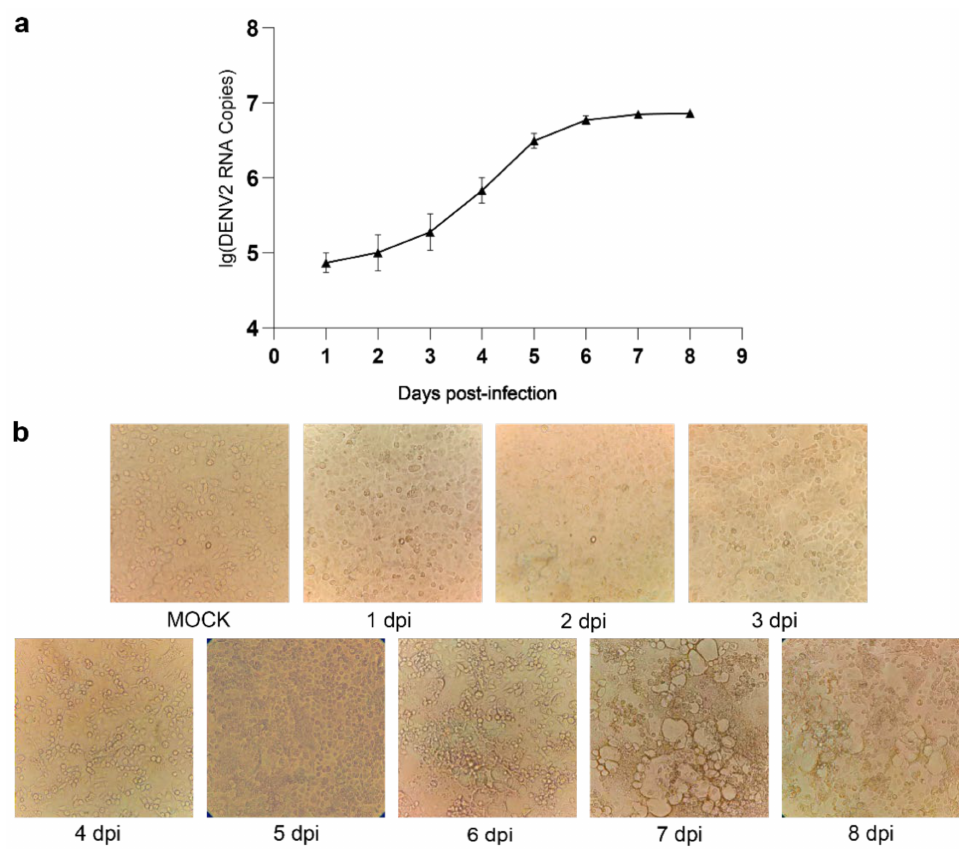
Figure 1. Viral growth kinetics of ( a ) and morphological changes in ( b ) C6/36 cells infected with DENV2. ( a ) The Y -axis label represents log10 (DENV2 RNA copies), and the X -axis label represents days post-infection with DENV2. ( b ) Mock refers to uninfected C6/36 cells (dpi: days post-infection). The magnification is 200 ×